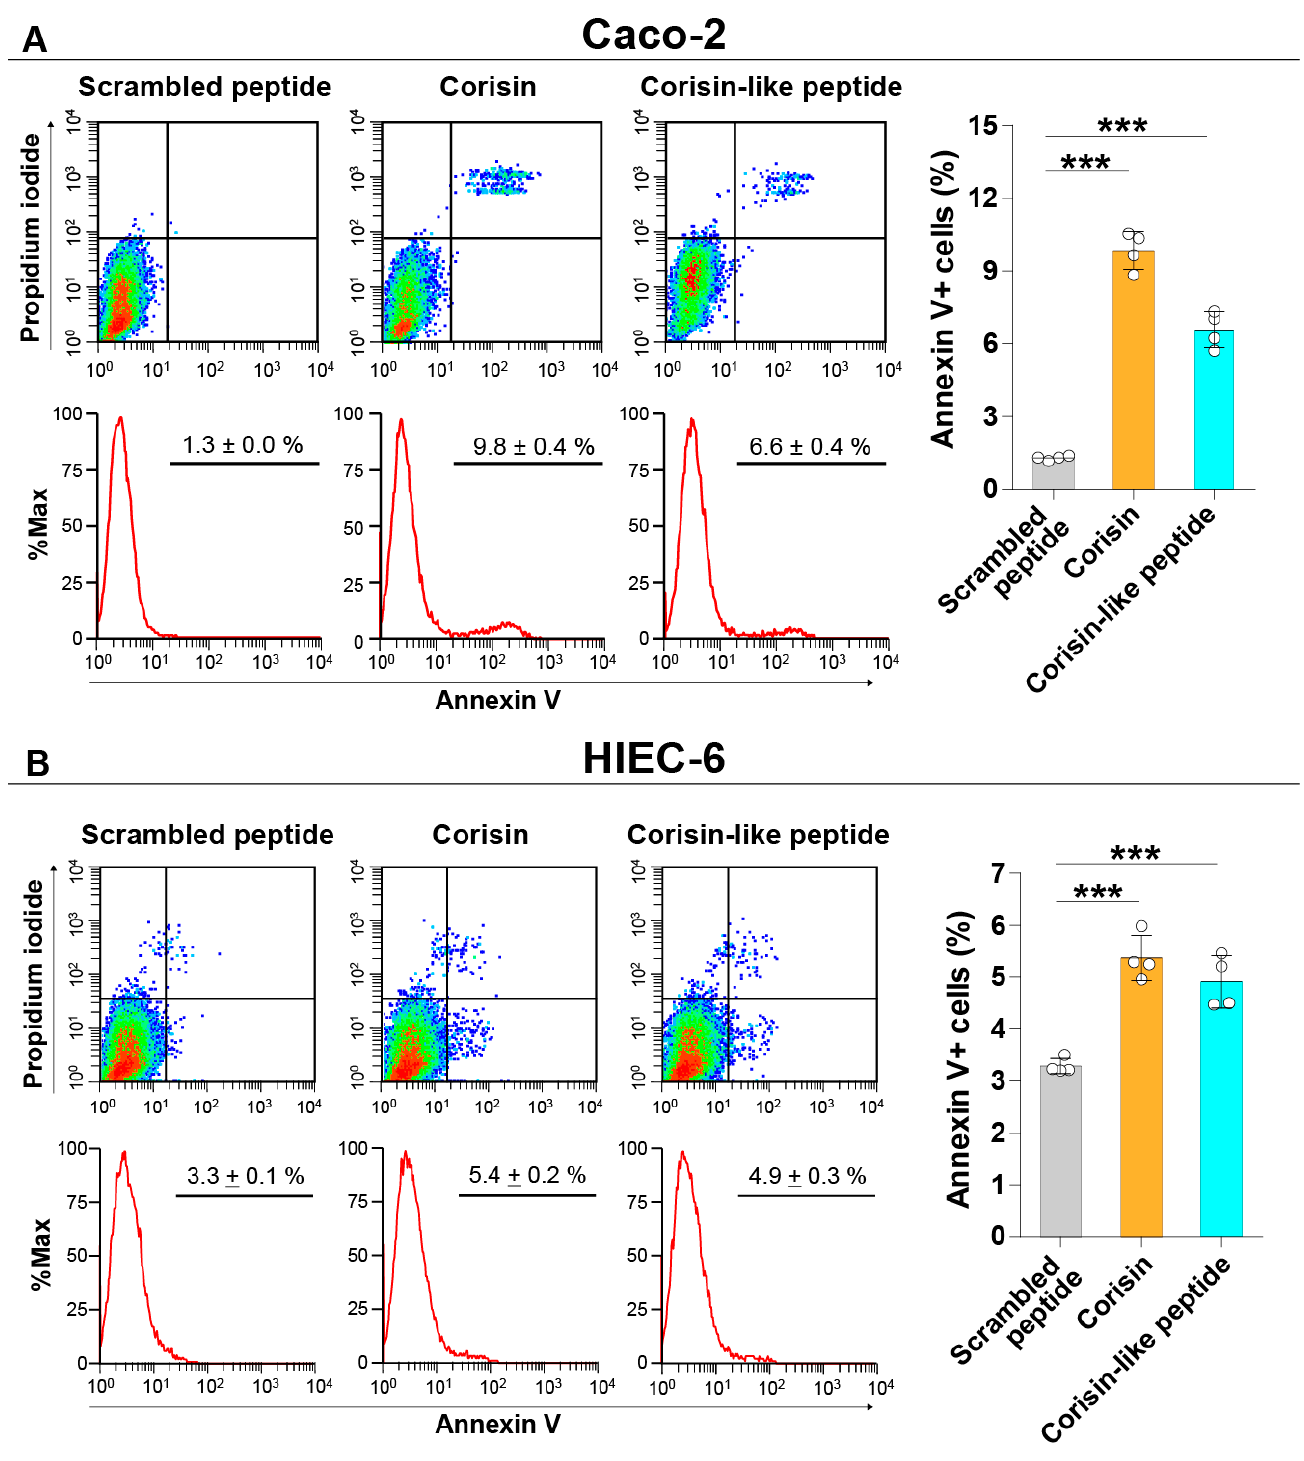
Figure 1. Corisin and corisin-like peptide induce apoptosis of intestinal cells. Caco-2 ( A ) and HIEC-6 ( B ) cells were cultured in the presence of corisin or corisin-like peptides for 48 h, and apoptosis was evaluated by flow cytometry. Data are expressed as the mean ± S.D. Statistical analysis by ANOVA with Newman-Keuls' test. *** p < 0.001.